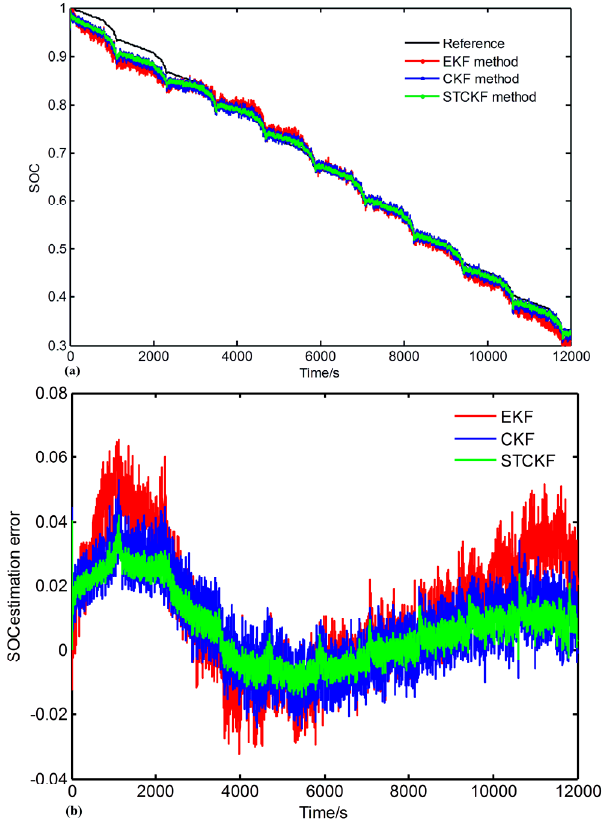
Figure 9. The SOC estimation results under New European Driving Cycle (NEDC) test: ( a ) SOC estimation profile; ( b ) SOC estimation error profile.